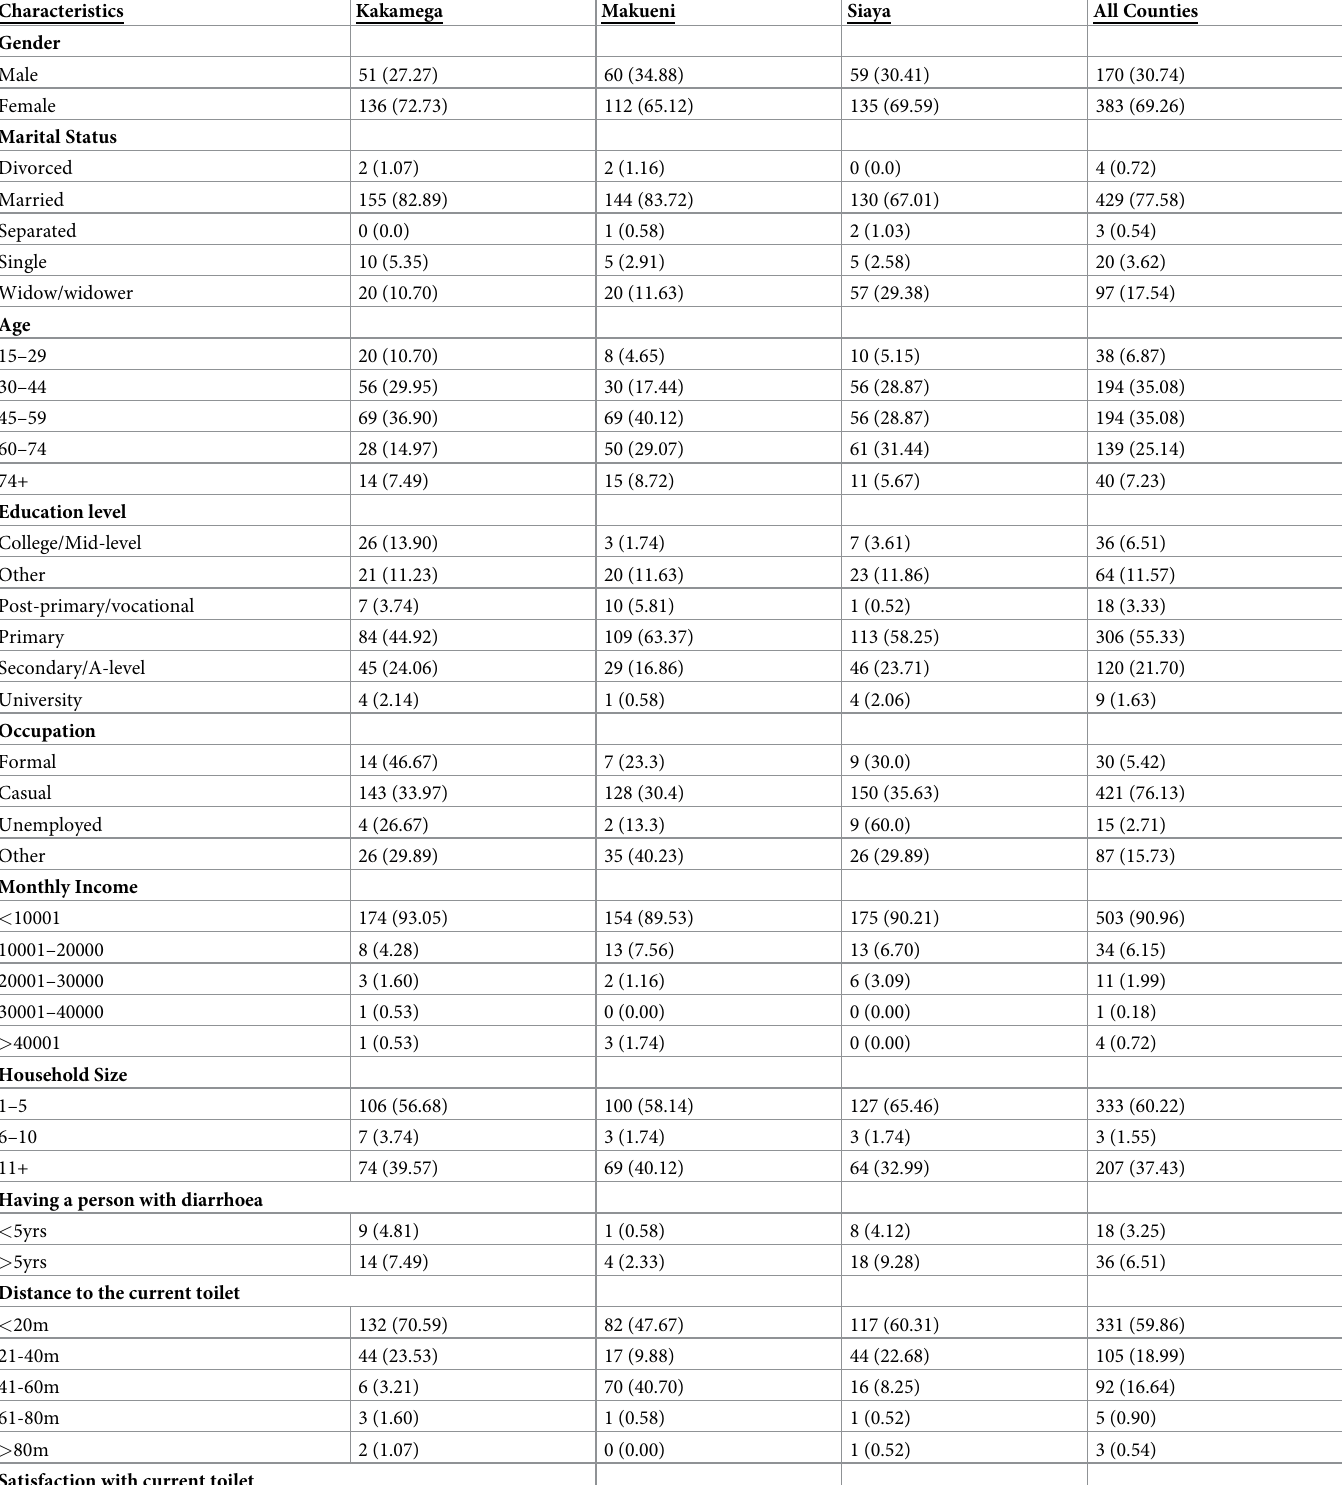
Table 1. Socio-economic characteristics in the study population (values in the parentheses are column percentages).